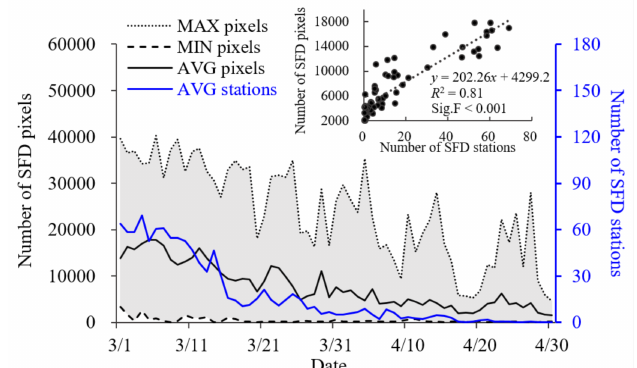
Figure 5. Daily dynamics in 2003–2020 for regional pixels and meteorological stations affected by SFD from March to April in the middle and lower reaches of the Yangtze River region, China. The black dotted line, dash-dotted line, and solid line are the regional maximum, minimum, and average pixels (left y -axis), respectively. The blue line is the average meteorological stations (right y -axis) in the large panel. Additionally, the 18-year average daily scatter plot of pixels vs. stations for SFD from March to April is also shown in the small inset panel.